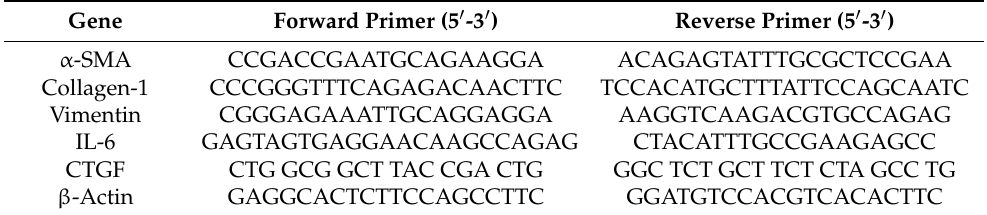
Table 1. The primers of human genes used.